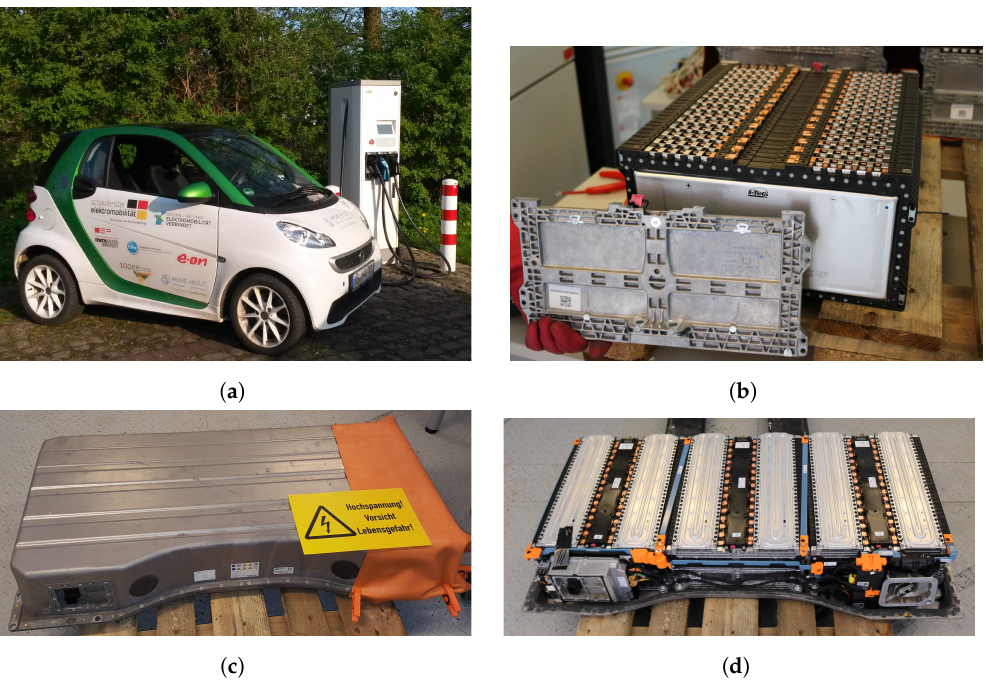
Figure 1. Pictures of the Smart e.d., its battery pack and a single battery pack module. ( a ) Smart e.d. (2013) in front of a charging station; ( b ) Single Module with outer plate taken off with a visible single cell of the 31 cells of the module; ( c ) Traction battery pack of Smart e.d.; ( d ) Traction battery pack of Smart e.d. without casing. 3 Modules with 31 cells each connected in series (93s1p) with liquid cooling plates and slave BMS. Bottom left:Master BMS. Bottom right: DC